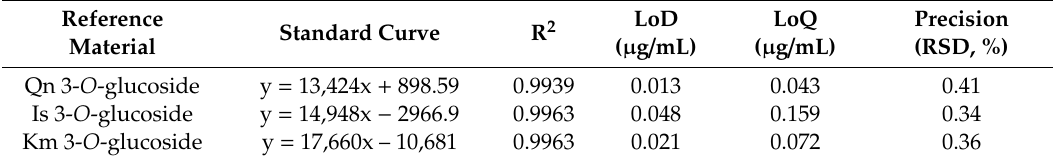
Table 2. Quantitative performance of the flavonoidic reference materials used in this study. Reference